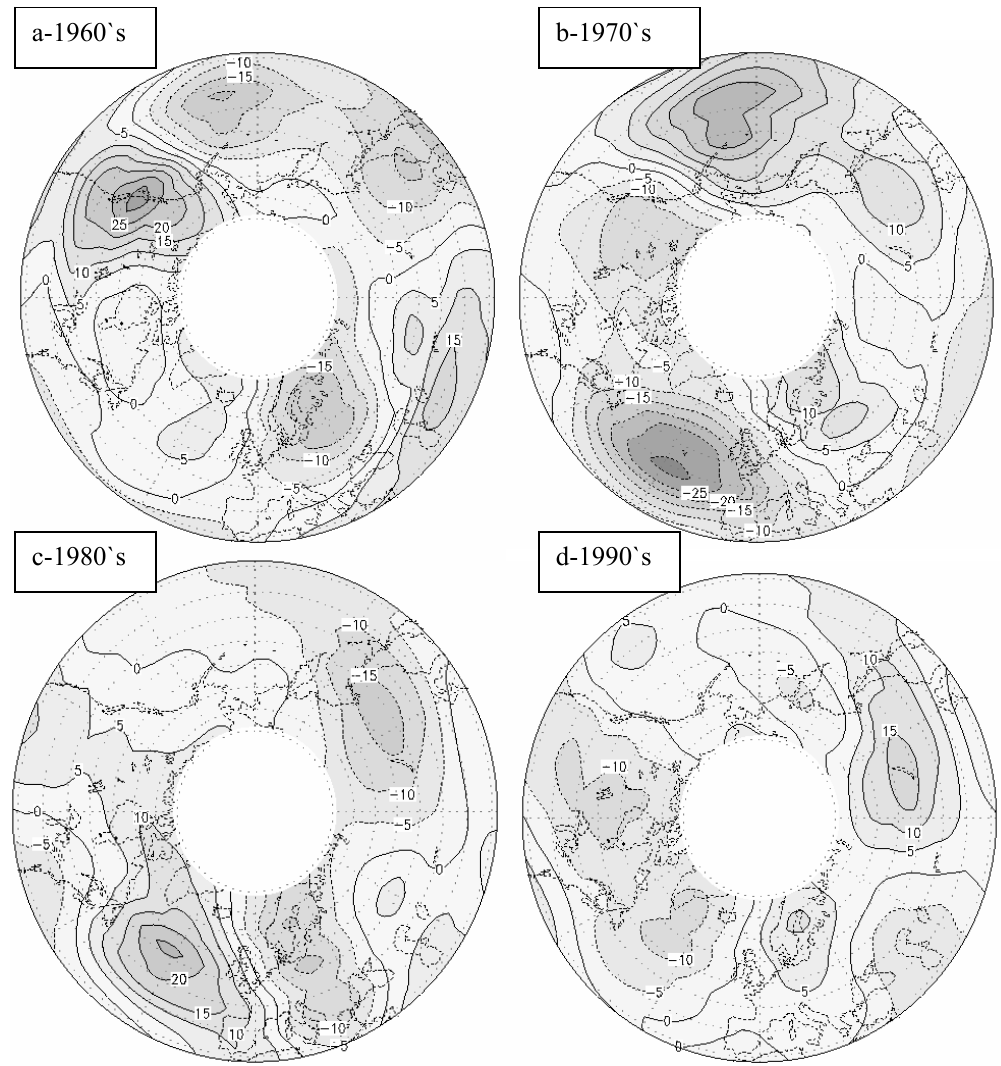
Fig. 5. Model results of mean decadal change in total ozone (DU) for the 1960s (a) , 1970s (b) , 1980s (c) and 1990s (d) calculated with differences of 5-year averages (end minus beginning of the decade) of geopotential heights for January. Figure 5: Model results of mean decadal change of total ozone (DU) for the 1960`s (a), 1970`s (b), 1980`s (c) and 1990`s (d) calculated with differences of 5 year averages (end minus agreement for the significant decadal change patterns beginning of the decade) of geopotential heights for January.